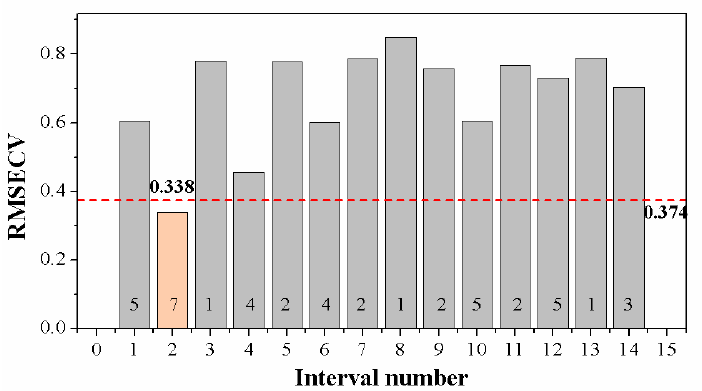
Figure 4. Performance of local partial least squares (PLS) models with 14 equidistant subintervals in 402.74–426.87 nm. The numbers above the X -axis are the optimal latent variables (LVs) in corresponding local PLS models. The lowest root mean squared error of cross-validation (RMSECV) of the second local PLS model was 0.338 (LVs = 7). The red dash-dot line represents the RMSECV of the global model (LVs = 11).